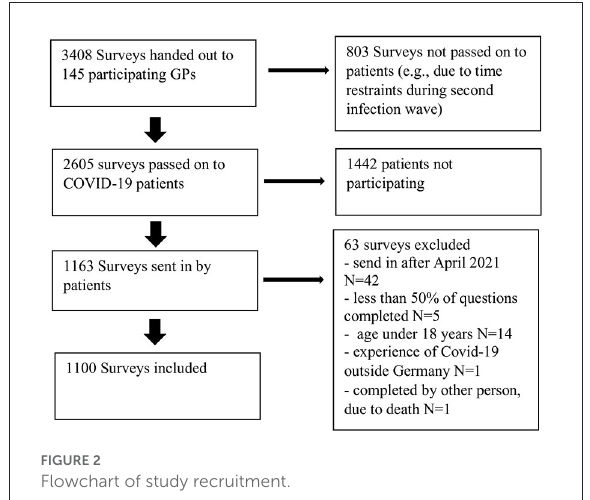
FIGURE2 Flowchart of study